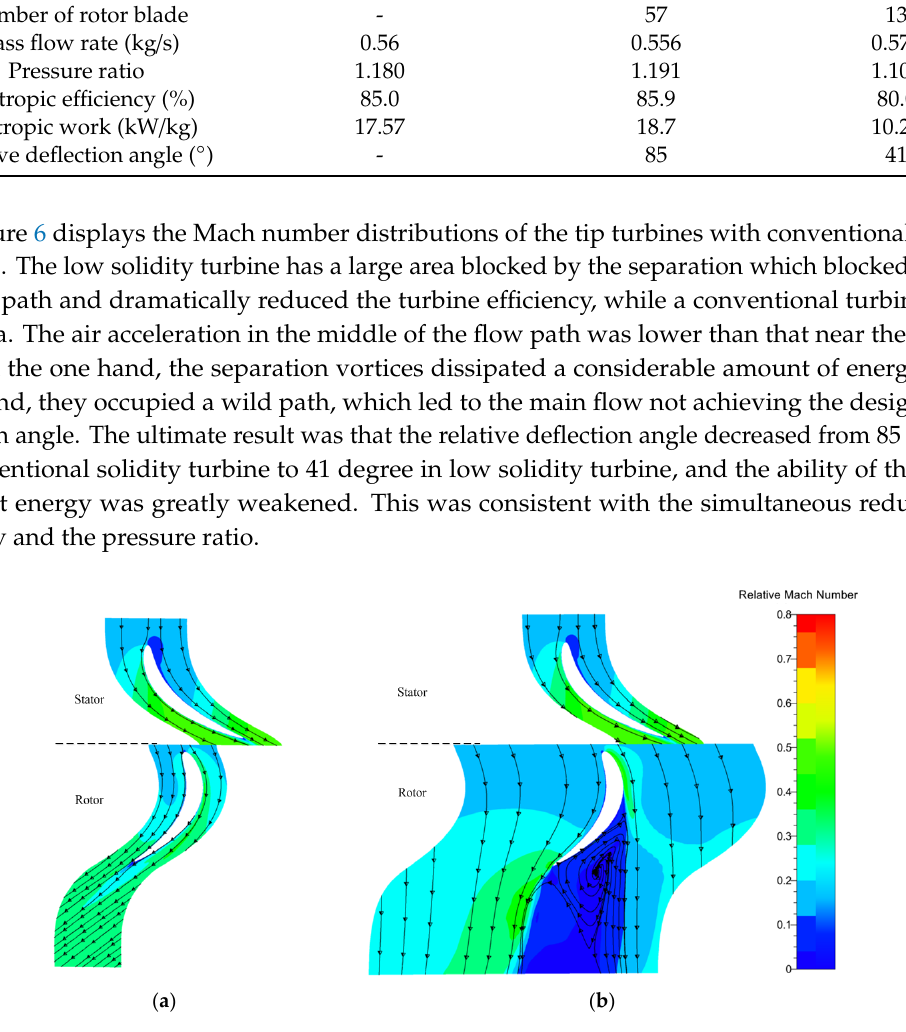
Figure 6. Mach number distributions of the tip turbines: ( a ) conventional solidity; ( b ) low solidity.